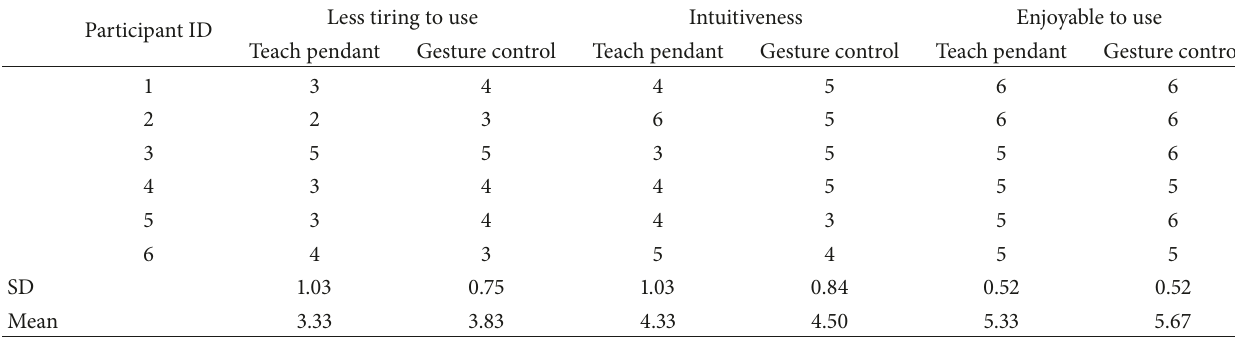
Table 3: Usability test results.